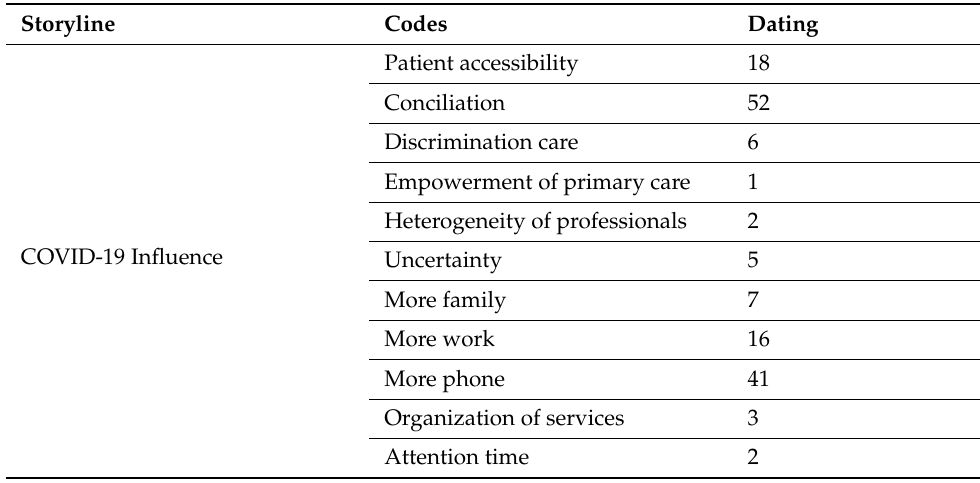
Table 2. Description of the categories, codes, and number of citations in the Atlas.ti analysis.